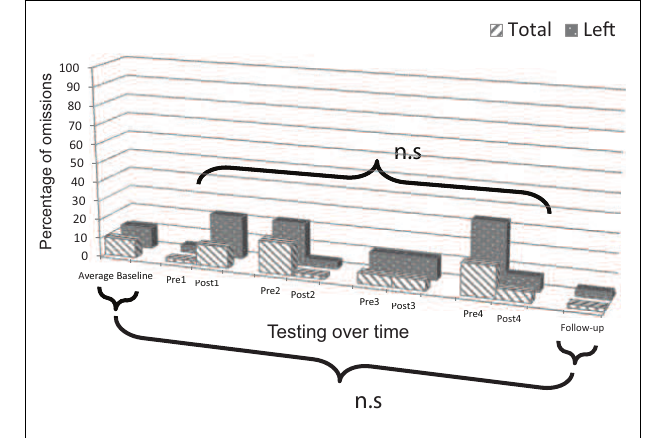
FIGURE 7 | Plot of Patient 2’s average baseline, intervention period, and follow-up responses on the BIT star cancellation test .